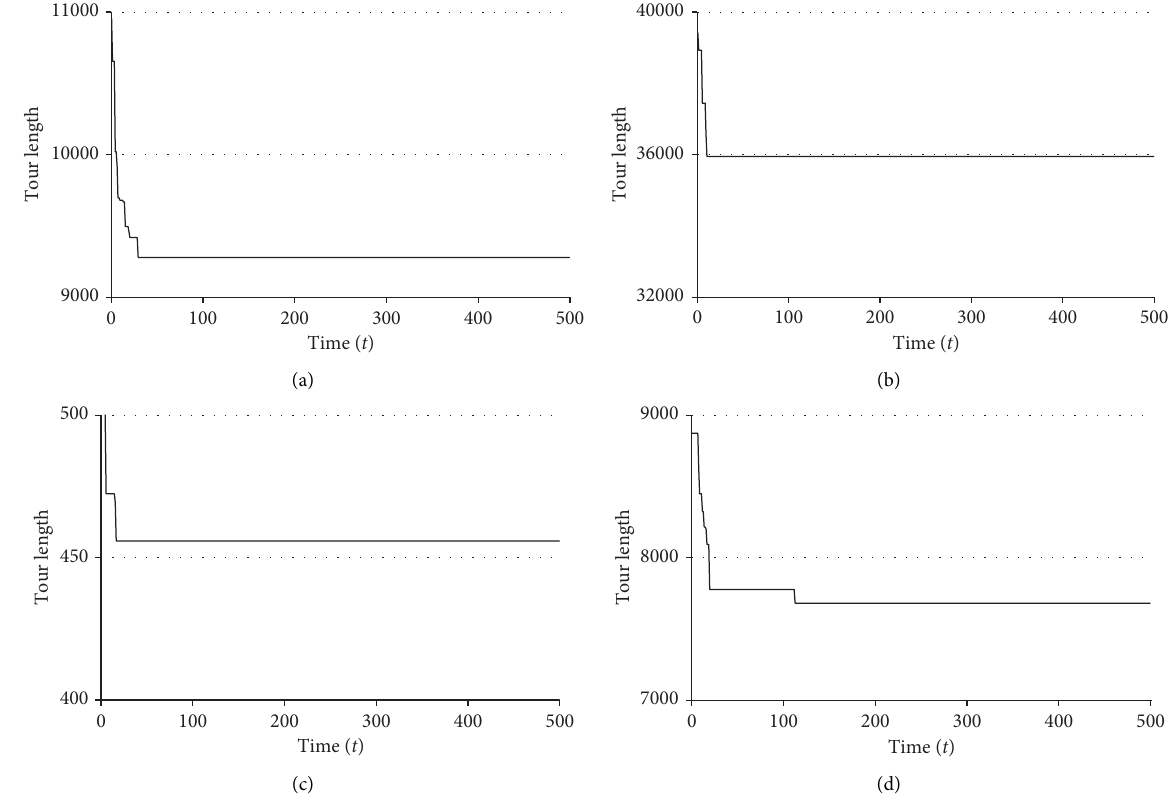
Figure 1: Best solution update in AS . (a) bayg29. (b) att48. (c) eil51. (d)